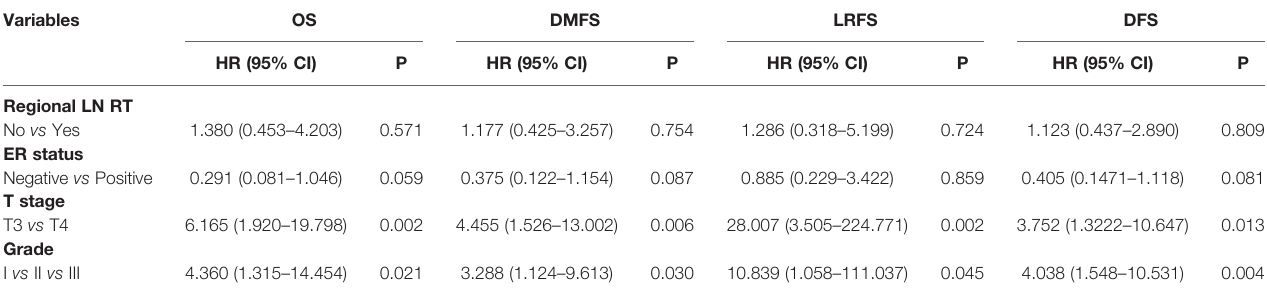
TABLE 3 | Multivariate cox regression analysis of prognostic factors.